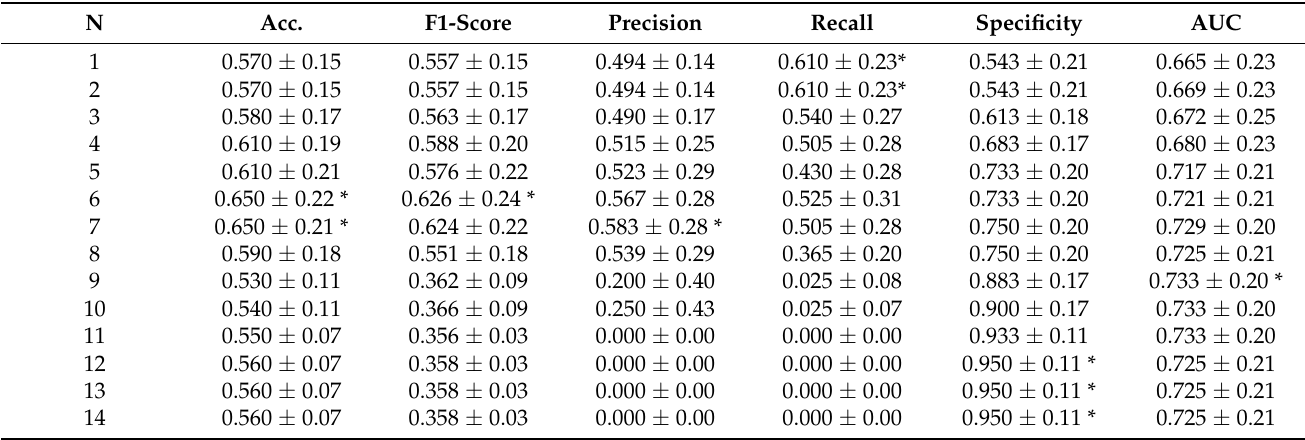
Table 5. Classification results for the support vector machine classifier.